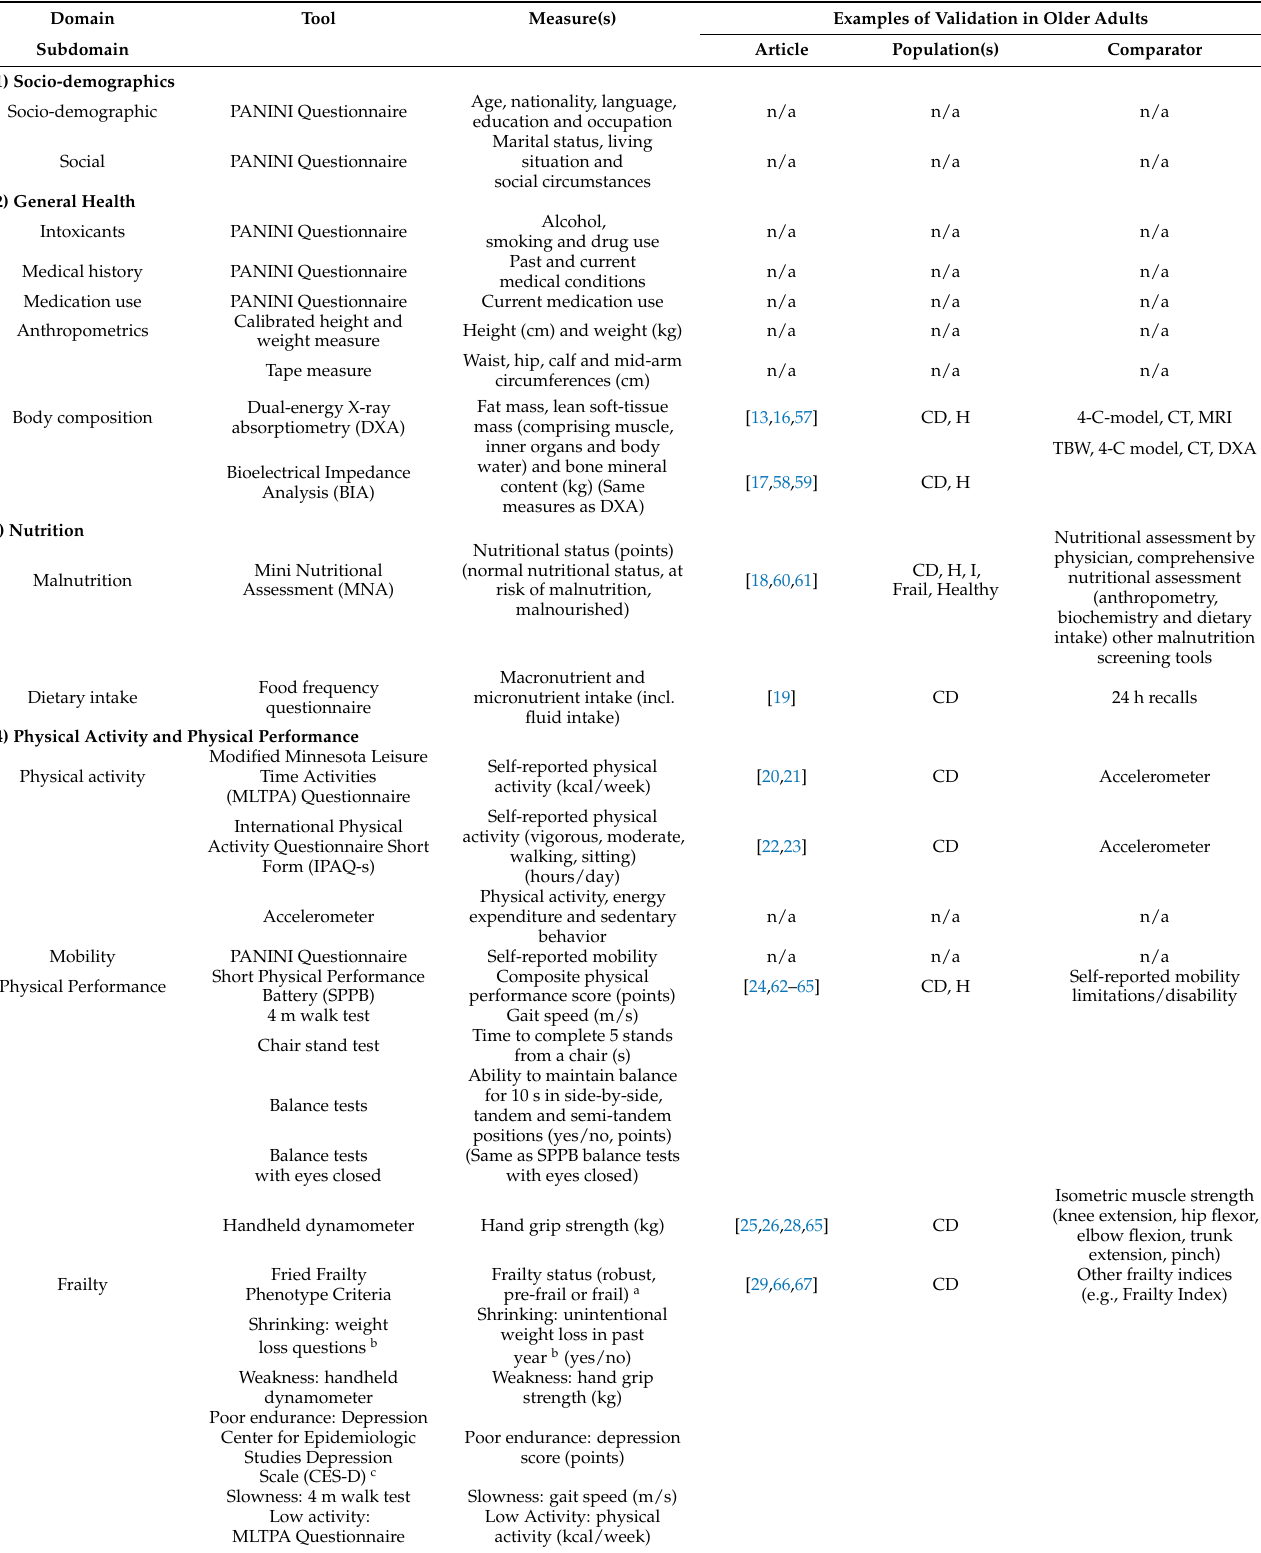
Table 1. Summary of the PANINI Toolkit tools and measures by